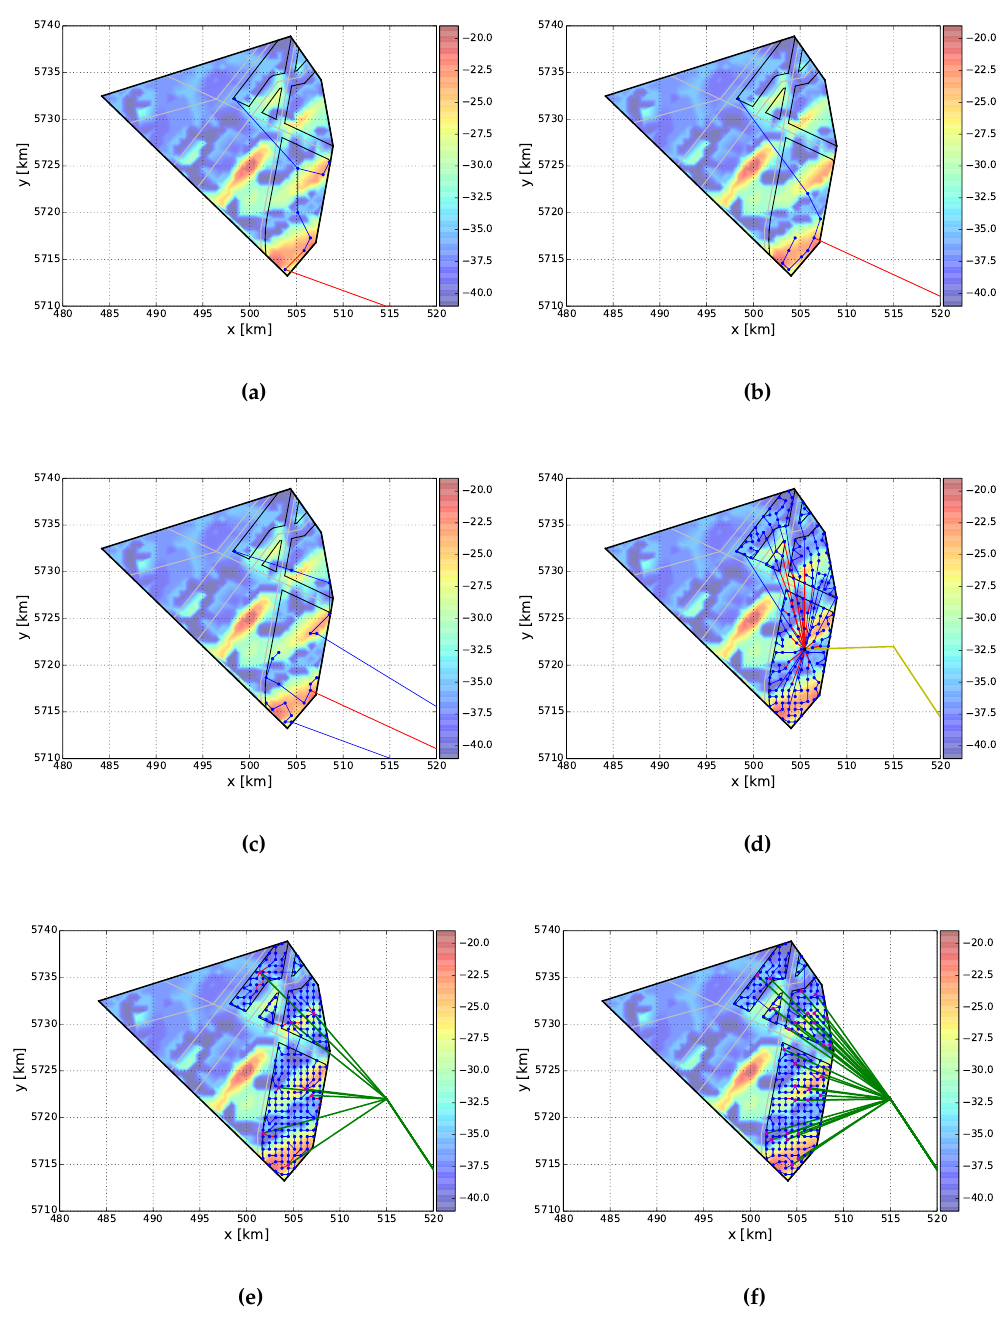
Figure 19. Layouts obtained with proposed optimization framework. Blue, purple and black circles represent, respectively, the 8 MW turbines, HVac and HVdc substations. Gray lines are existing pipelines and telecom cables, blue and red lines are the collection system cables and green and yellow lines are the exporting HVac and HVdc cables, respectively. ( a ) Layout number 3; ( b ) Layout number 5; ( c ) Layout number 18; ( d ) Layout number 248; ( e ) Layout number 322; ( f ) Layout number